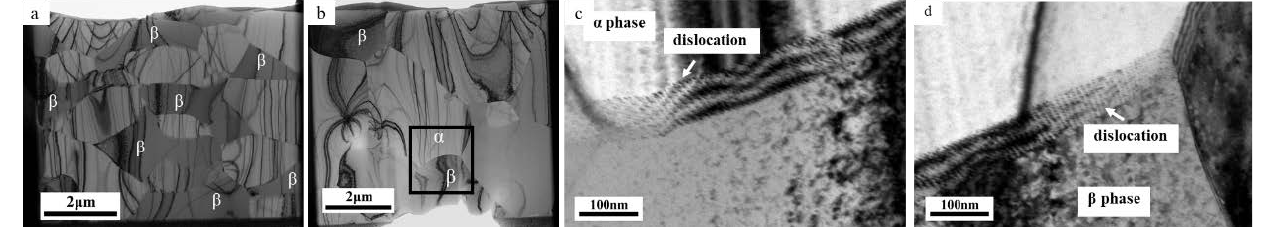
Figure 12. Transmission electron micrographs of specimen deformed at 760 °C: ( a ) at the grip position and ( b – d ) at the middle of the gauge section.